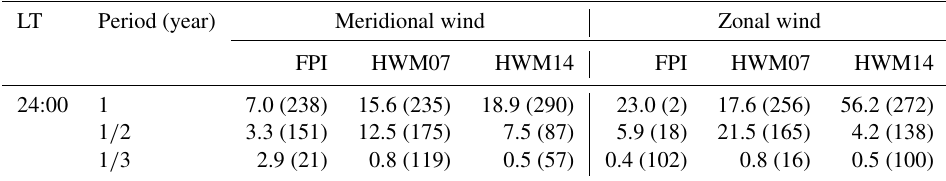
Table 2. The annual, semiannual, and terannual harmonic fits to the meridional and zonal winds for the Xinglong FPI data (after Table 1 of Yuan et al., 2013), HWM07, and HWM14 at local midnight (24:00LT). The amplitude is in ms − 1 and the phase (in parentheses) is in DOY. LT Period (year) Meridional wind Zonal wind FPI HWM07 HWM14 FPI HWM07 HWM14 24:00 1 7.0 (238) 15.6 (235) 18.9 (290) 23.0